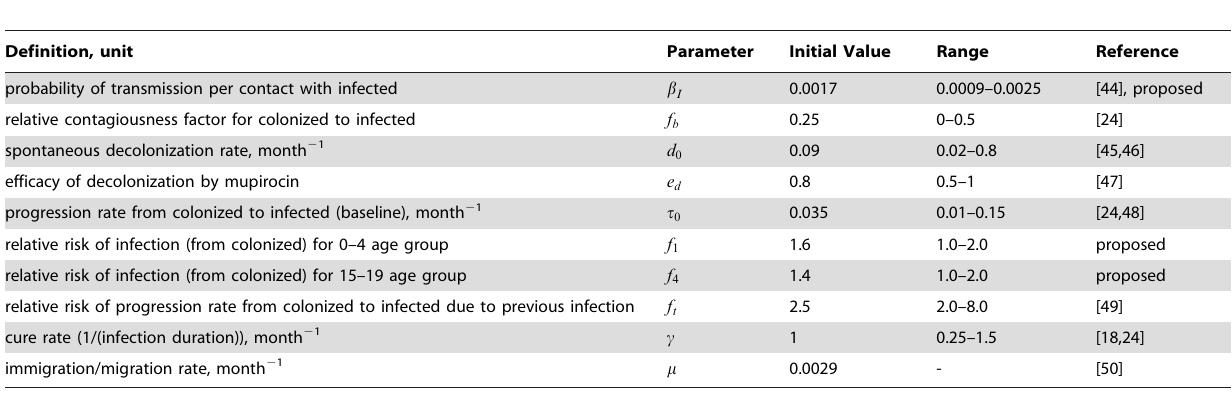
Table 1. Epidemiological parameters: definition, symbol, and initial value and range used in parameter estimation using the MCMC